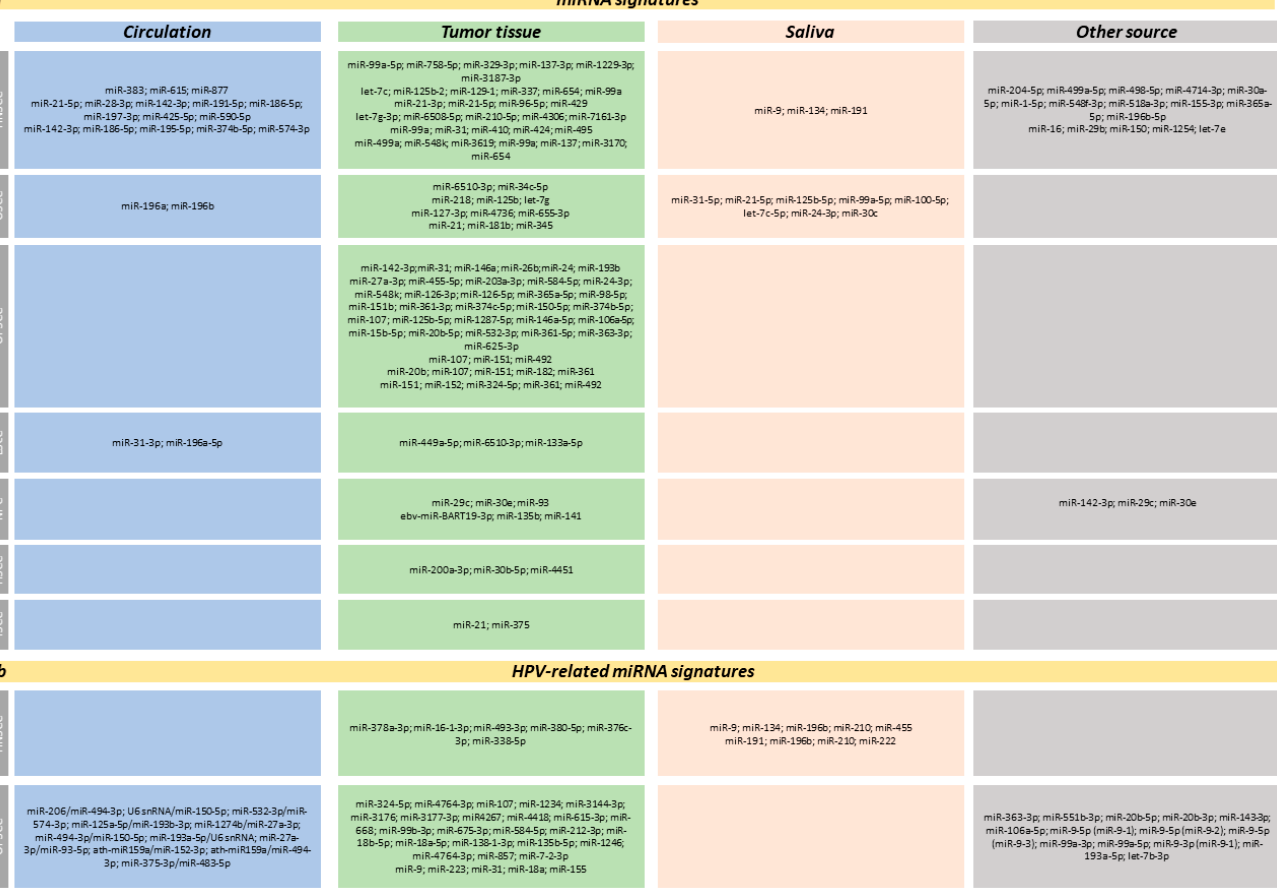
Figure 3. ( a ) Overview of miRNAs signatures in HNSCC subtypes; ( b ) miRNA signatures detected in HPV+ HNSCC and OPSCC patients. The miRNA signatures are detected and evaluated in the circu- lation (serum and/or plasma), tumor tissues, and saliva of HNSCC patients and in vitro, in HNSCC cell lines. The term other source refers to data derived from literature and bioinformatic analyses.